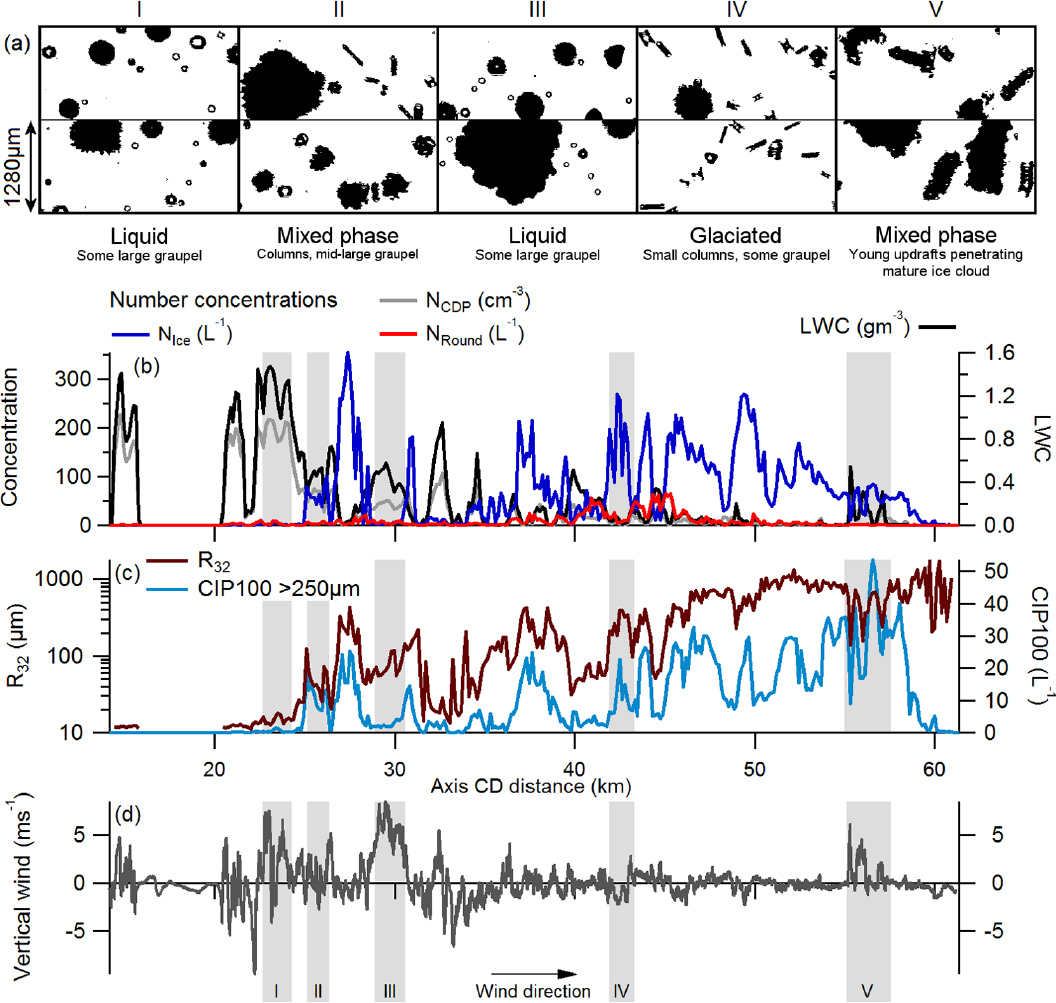
Figure 5. In situ measurements made by the BAe-146 on longitudinal run 11.2 along axis CD. The run was made at an altitude of 3.5km ( T ∼ − 5 ◦ C) between 13:34:55 and 13:40:30UTC. In panel (b) , the number concentrations use the left axis, and the units are defined according to the measurement probe. The 2DS categories are defined in Appendix A1. The images shown were recorded by the 2DS and show representative images from the sections marked by grey boxes and labelled with Roman numerals. Only images > 50 pixels are shown, and they are not classified by